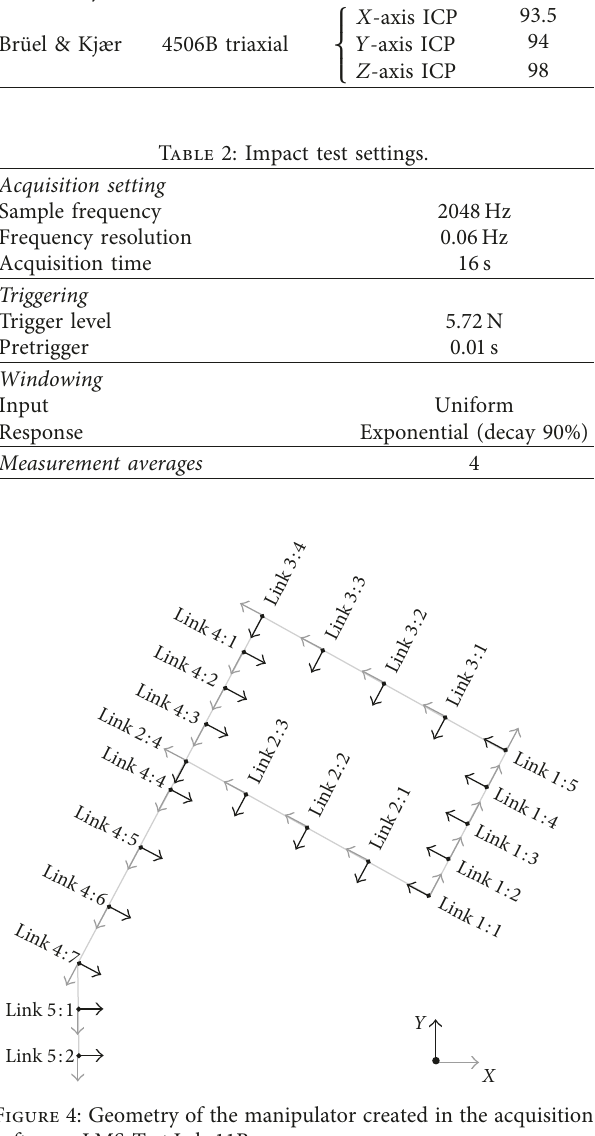
Figure 4: Geometry of the manipulator created in the acquisition software, LMS Test.Lab